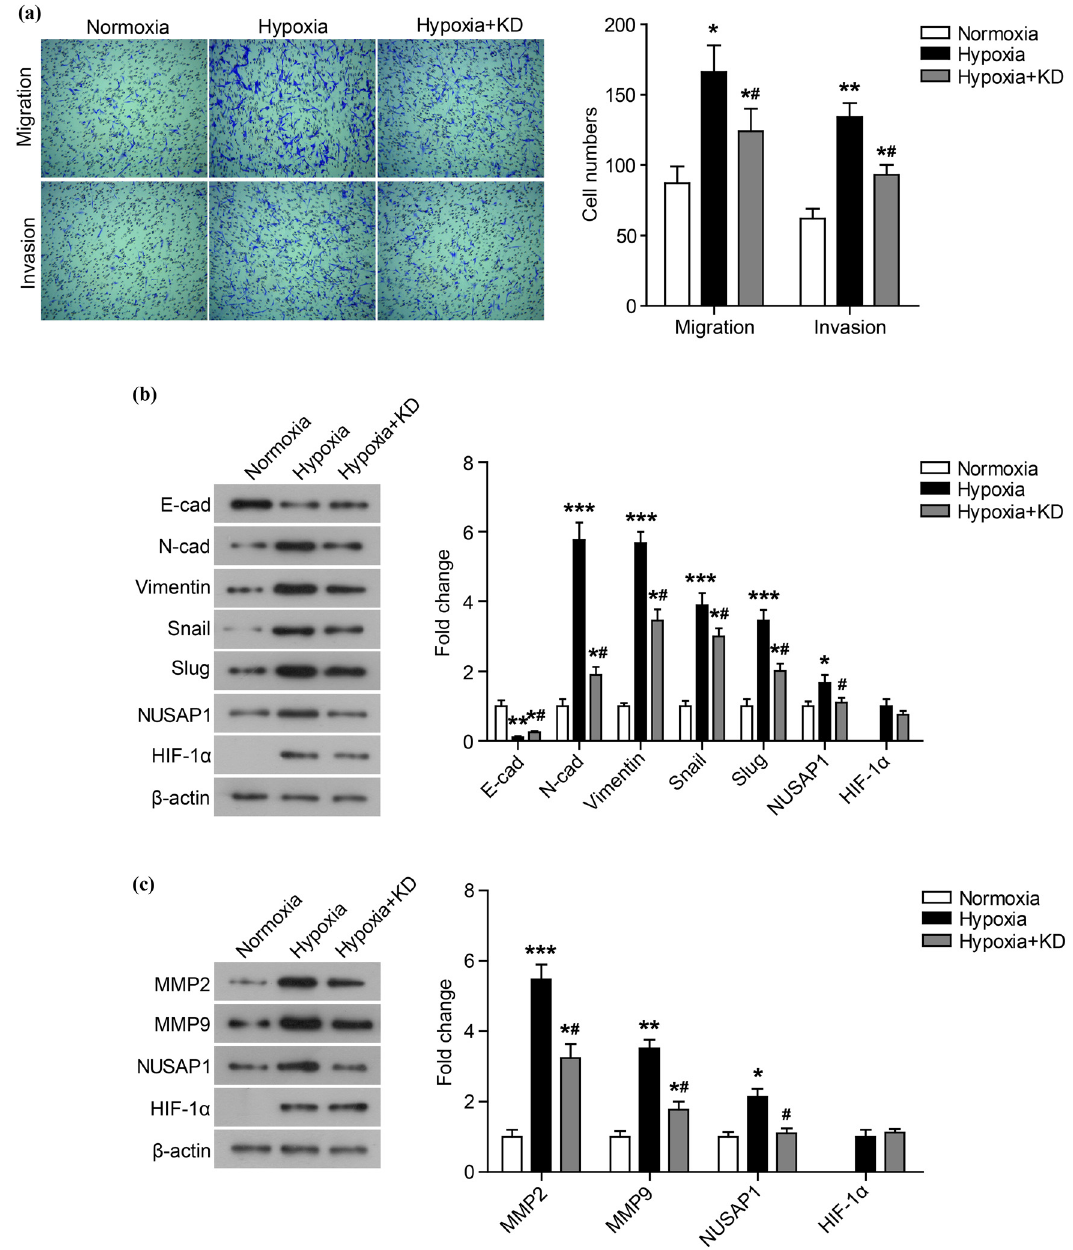
Figure 2: Knockdown of NUSAP1 represses the migration and invasion of MG63 cells under hypoxia. ( a ) The migration and invasion of MG63 cells whose NUSAP1 expression was knocked down ( Hypoxia + KD ) under hypoxia condition was measured using transwell assay. ( b ) The expression of EMT - related proteins was detected using western blot. ( c ) The expression of MMP family membranes was detected using western blot. All experiments were independently carried out in three replicates. * P < 0.05, ** P < 0.01, *** P < 0.001, compared with normoxia group; # P < 0.05, compared with Hypoxia